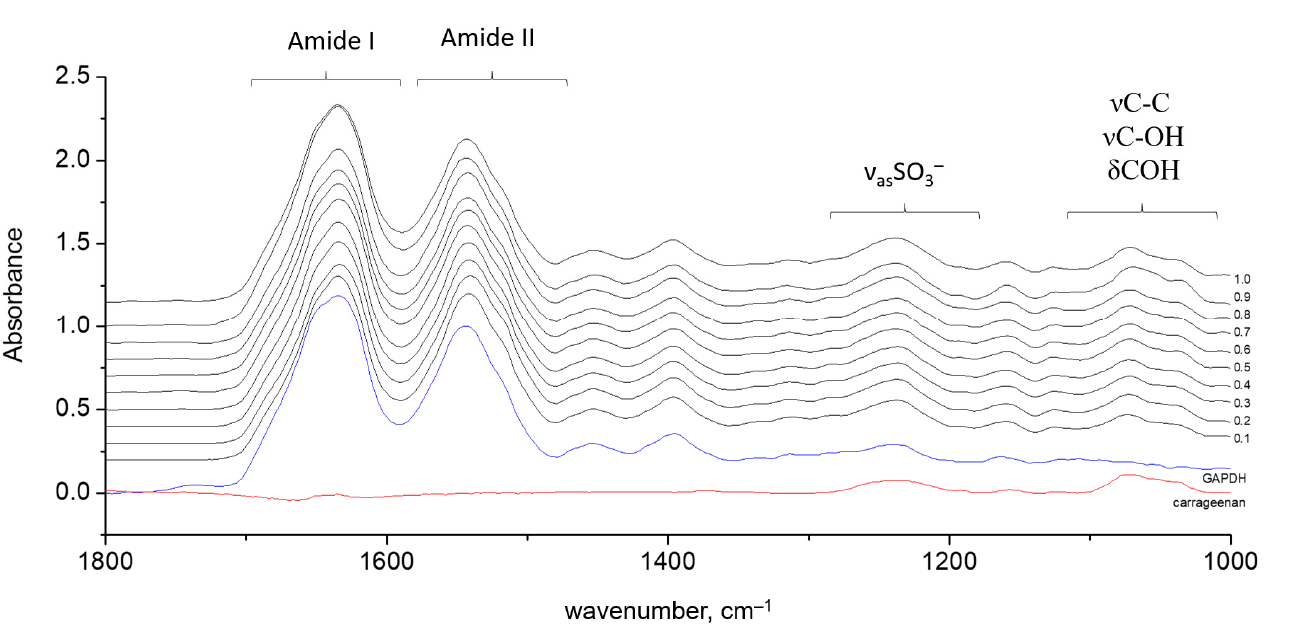
Figure 2. Spectra of κ -carrageenan—GAPDH gels obtained by mixing at different mass ratios of 0.1, 0.2, 0.3, 0.4, 0.5, 0.6, 0.7, 0.8, 0.9 and 1.0. The reference spectra of pure GAPDH (blue) and κ -carrageenan in coil conformation (red) are given for comparison.